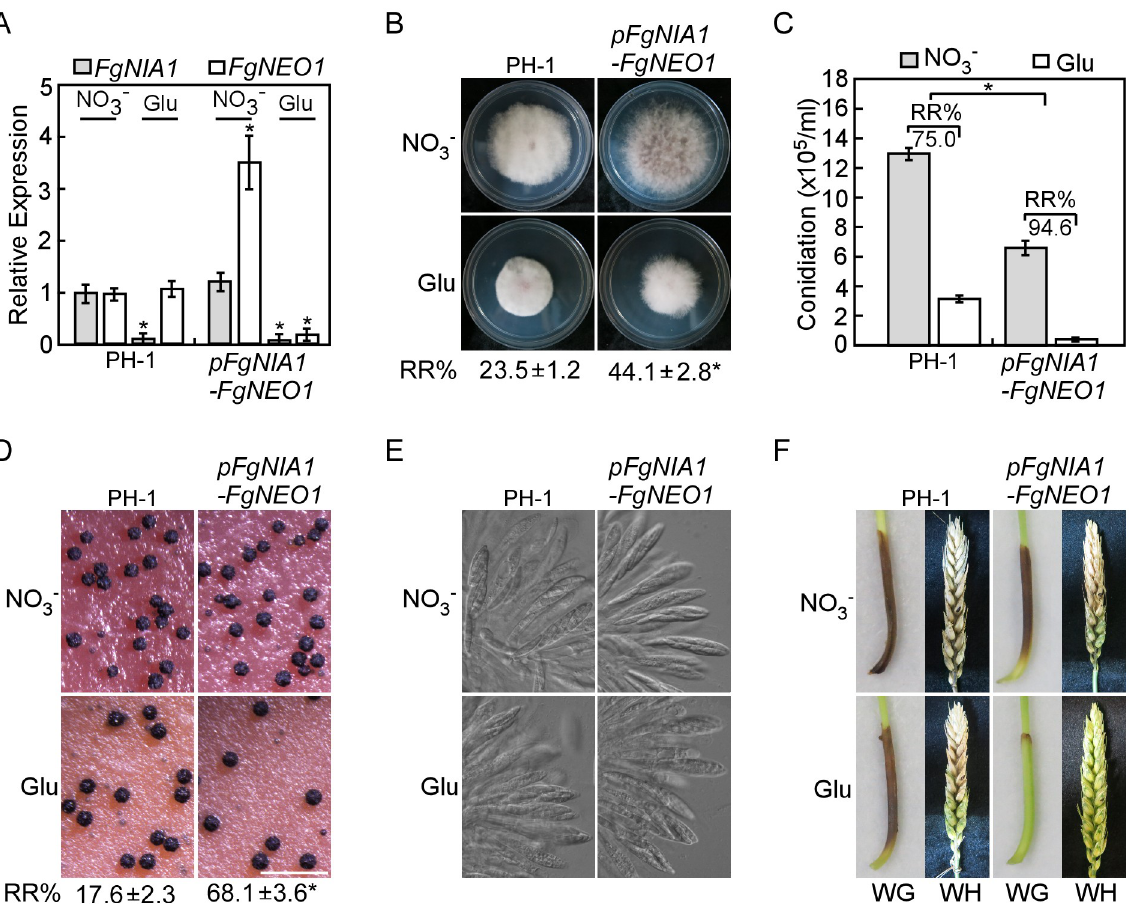
Fig 8. FgNeo1 is involved in vegetative growth, asexual/sexual development and virulence. (A) Quantitative RT-PCR monitoring of FgNIA1 and FgNEO1 expression in the wild type PH-1 and transformant pFgNIA1-FgNEO1 under the control of pFgNIA1 . The strains were cultured in MM+NO 3- and MM+Glu, respectively. (B) Colony morphology of the indicated strains on different media, and statistical analysis of the percentage of relative reduction (RR) in growth. (C) Quantification and analysis of the percentage of relative reduction in conidial production. (D and E) Perithecia, asci formation and morphology of the indicated strains. Bar = 1 mm. (F) Conidial suspensions of the indicated strains with NO 3- or Glu, were drop-inoculated onto wheat germs (WG) or injected into the flowering wheat heads (WH). Photographs were taken at 10 dpi and 14 dpi, respectively. Error bars represent the SD and asterisks indicate statistically significant differences ( p < 0.01).